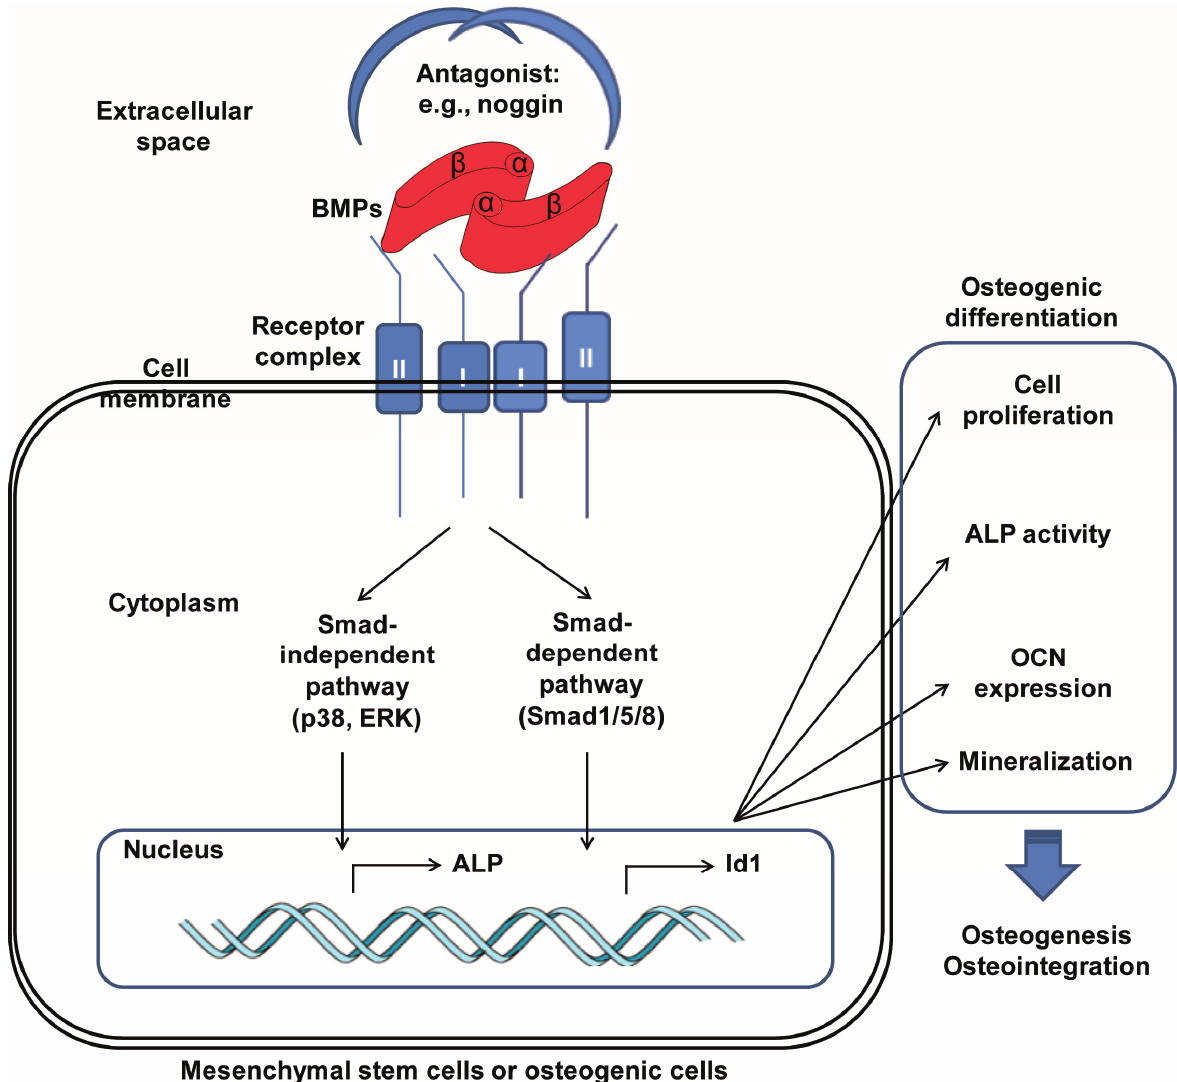
Figure 1. Schematic illustrating the signalling of bone morphogenetic proteins (BMPs) to induce osteogenic differentiation of mesenchymal stem cells or osteogenic cells. ALP: alkaline phosphatase; OCN: osteocalcin; Id: inhibitor of DNA binding 1; ERK: extracellular signal-related